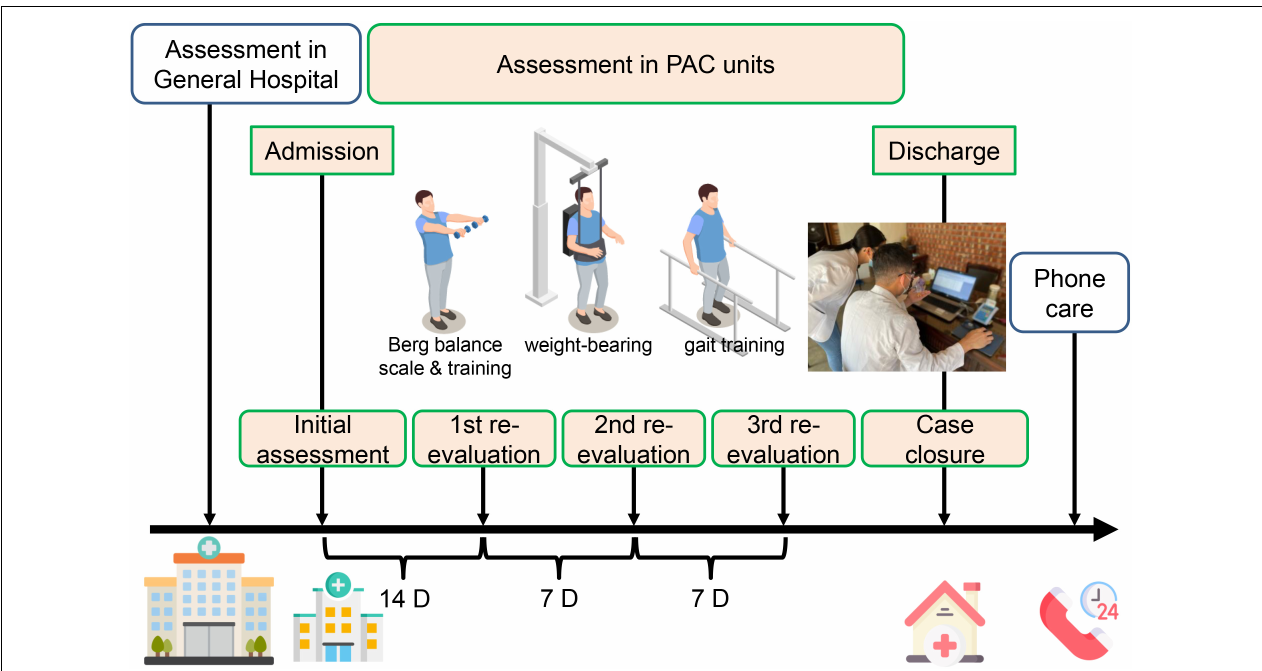
FIGURE 1 | A simple schematic diagram illustrating the assessment and measurement protocol executed in the general hospital, followed by post-acute care units. PAC, post-acute care. Some images are edited by Freepik free website and software,